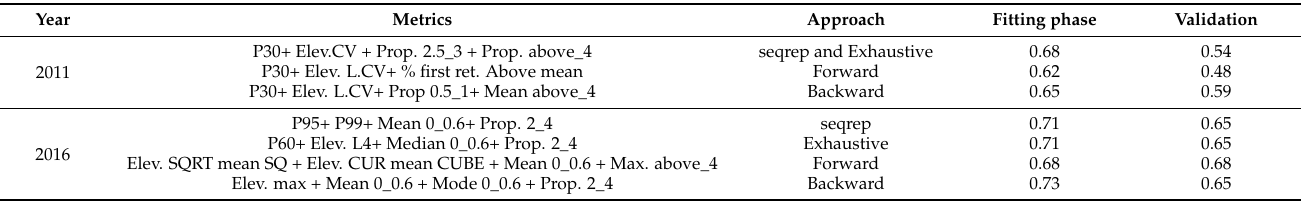
Table 2. Overall accuracy of all subsect selection selected metrics using SVMl classification method. seqrep stands for sequential